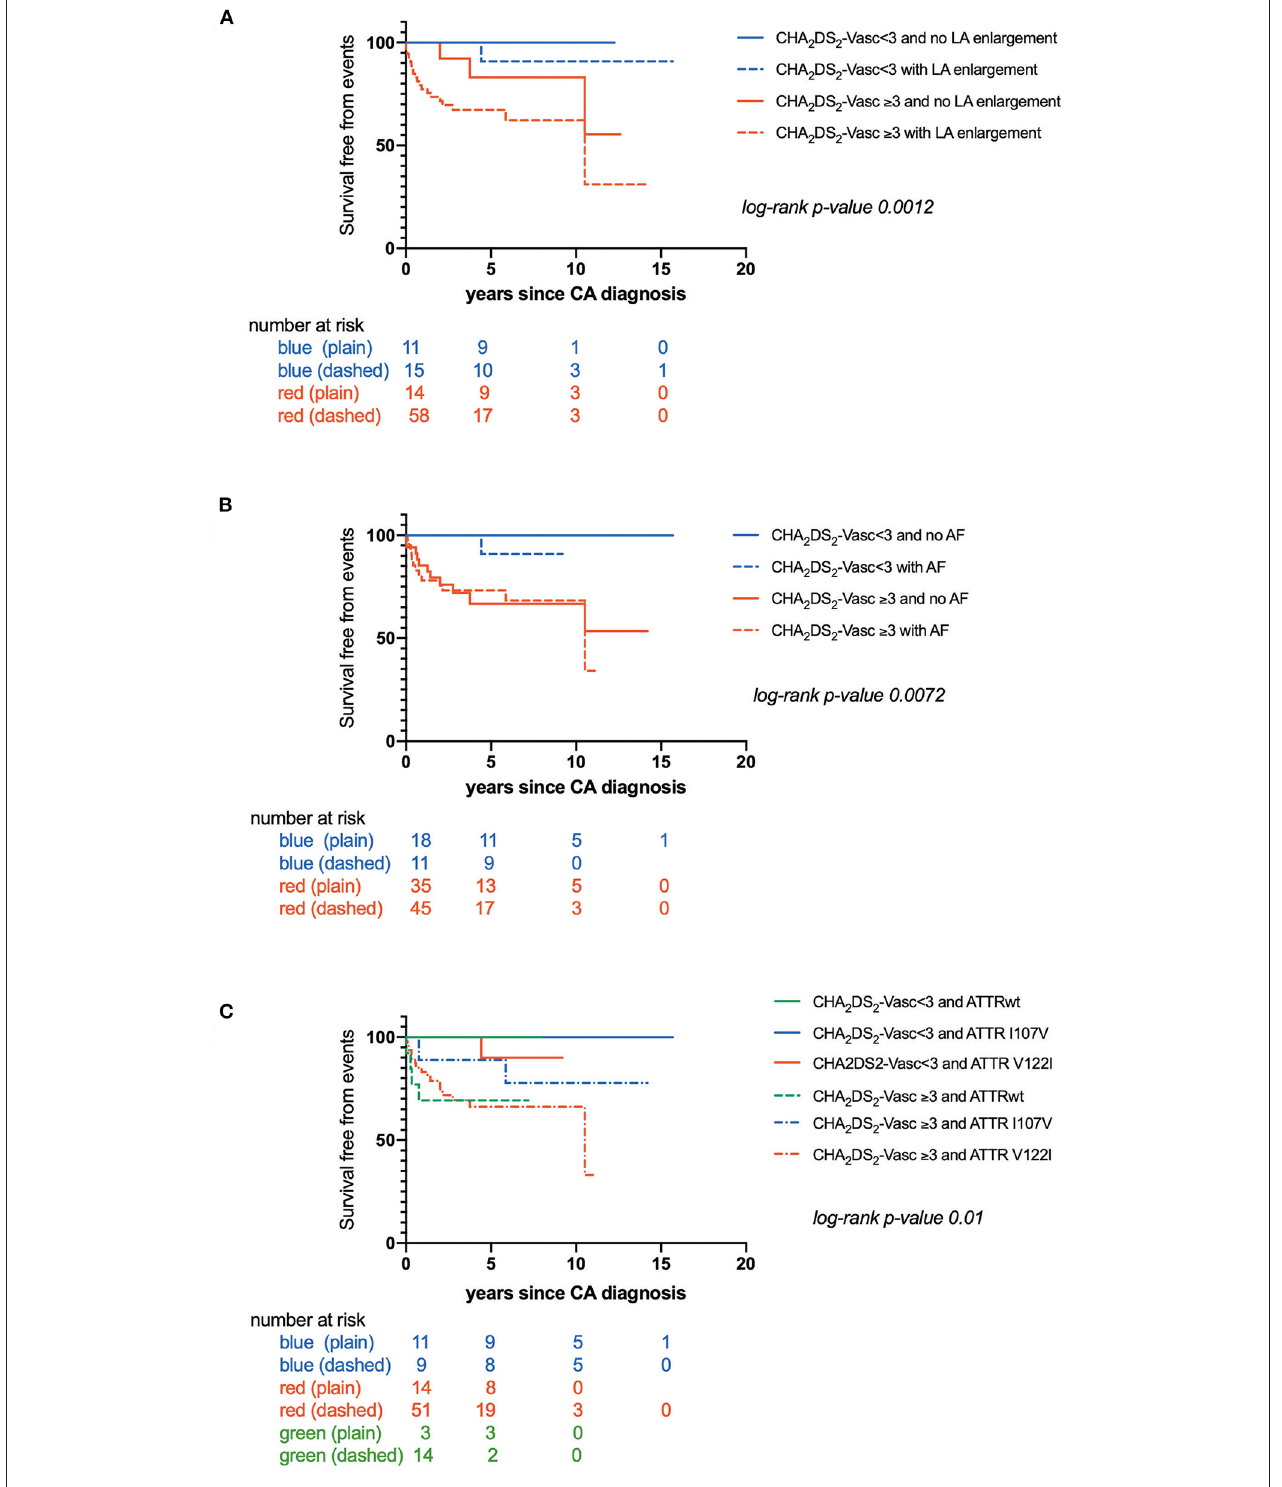
FIGURE 2 | (A) Kaplan-Maier analysis of survival free from Cerebral Ischemic events (CIE) according to CHA 2 DS 2 -VASc score and left atrial enlargement; (B) Kaplan-Maier analysis of survival free from Cerebral Ischemic events (CIE) according to CHA 2 DS 2 -VASc score and atrial fibrillation; (C) Kaplan-Maier analysis of survival free from Cerebral Ischemic events (CIE) according to CHA 2 DS 2 -VASc score and transthyretin cardiac amyloidosis (CATTR) genotype.